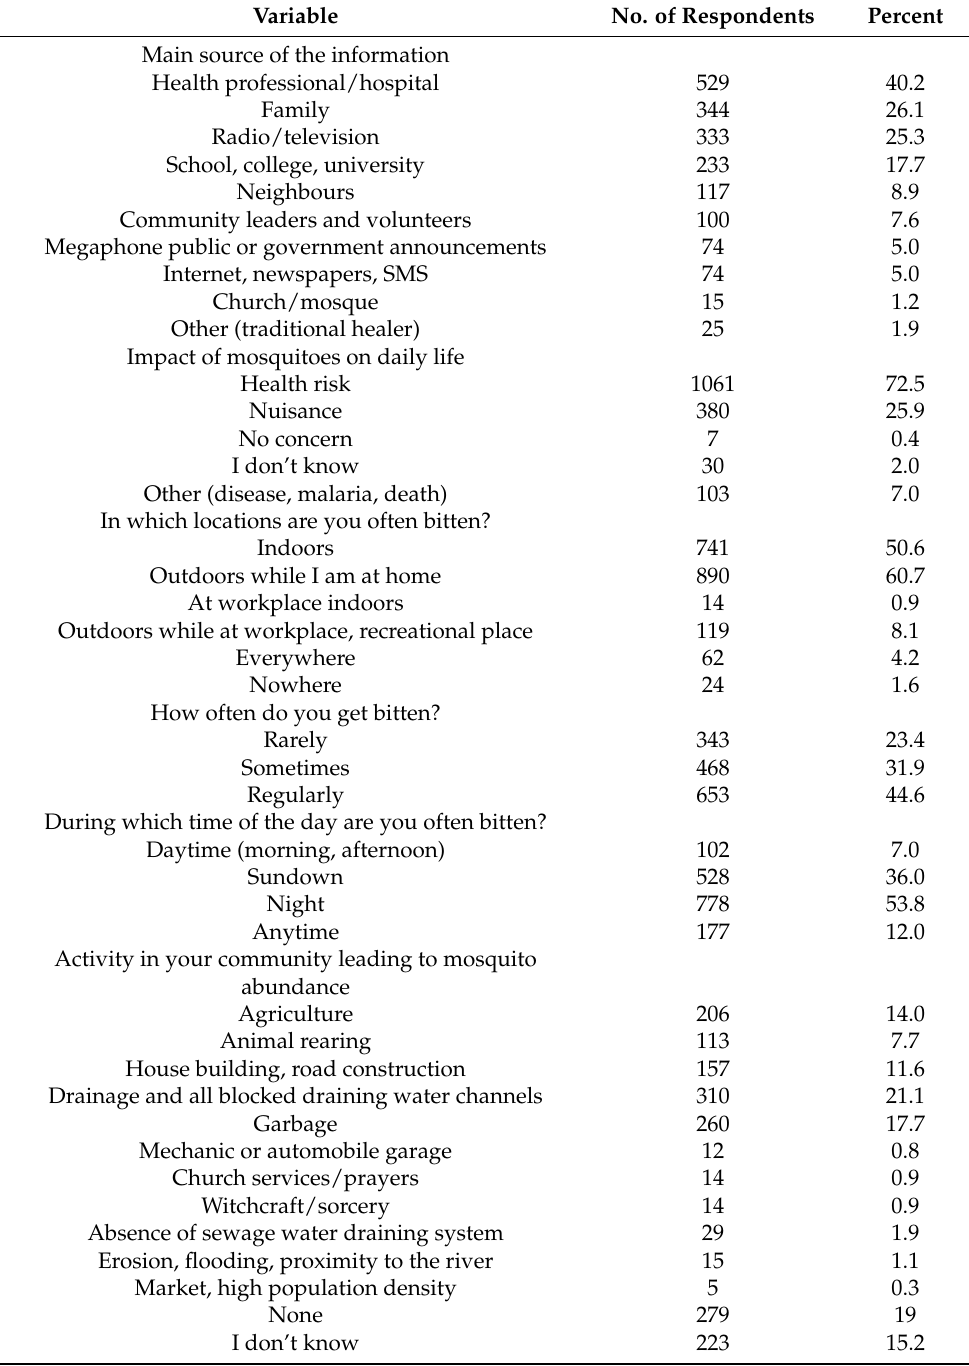
Table 7. Attitudes related to mosquito and mosquito-borne viral